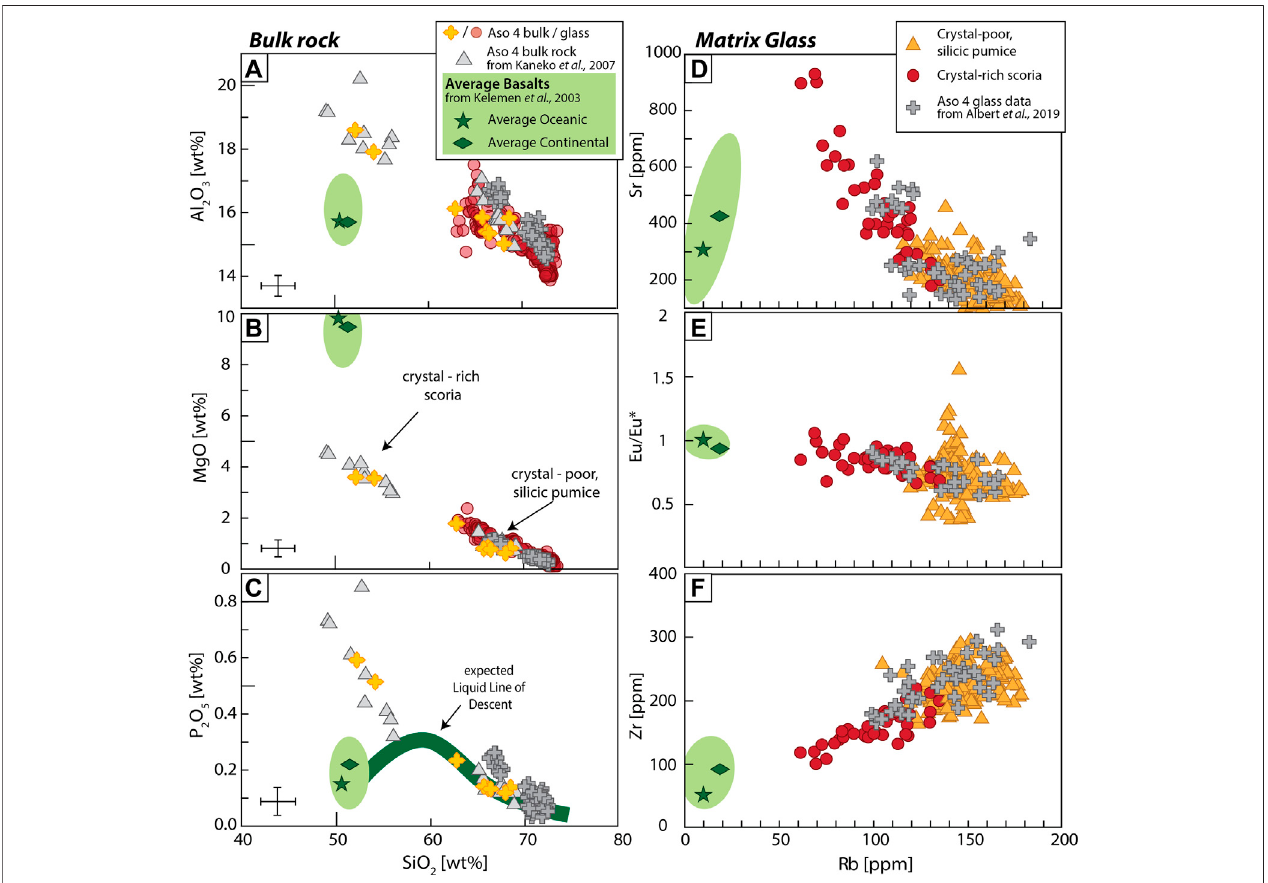
FIGURE 2 | Geochemical overview of Aso-4 bulk rock and matrix glass compositions. Colored symbols refer to data from this study, while gray triangles and crosses represent literature data from Kaneko et al., (2007) and Albert et al., (2019), respectively. Bulk rock major elements (A) Al 2 O 3 , (B) MgO and (C) P 2 O 5 are plotted vs. SiO 2 showing a compositional gap between SiO 2 concentrations of 57 – 63 wt%. Matrix glass trace elements (D) Sr, (E) Eu/Eu* (Eu* (cid:2) Eu N /(Sm N *Gd N ) 1/2 ) and (F) Zr are plotted vs. Rb showing partial overlap between matrix glasses from crystal-poor pumices and crystal-rich scoria. Light green areas mark average basaltic compositions taken from literature (Kelemen et al., 2003) showing a pronounced shift of crystal-rich scoria to average basaltic compositions. Error bars given in (A) – (C) refer to errors of whole rock data from this study, errors of matrix glass measurements are smaller than the symbol.